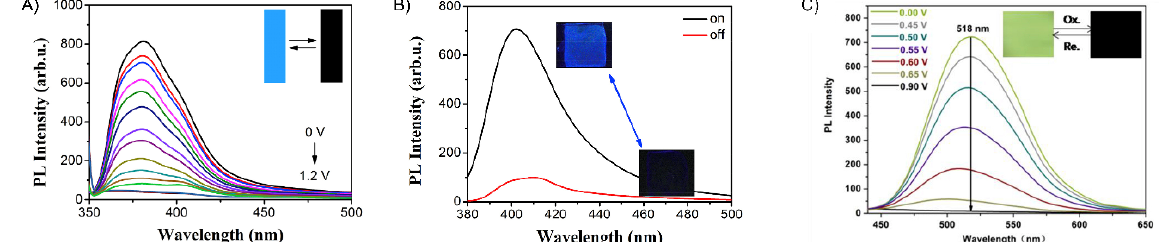
Figure 14. Electrofluorochromism of P4b in a half ‐ device ( A ), P4a in a full device ( B ), and P5 in half ‐ device ( C ) [138,139]. Insets: photographs showing the emission on/off with applied potential. ( A , B ) Reproduced with permission from ref. [138]. Copyright 2020 Elsevier. ( B ) Reproduced with permission from ref. [139]. Copyright 2019 Elsevier.